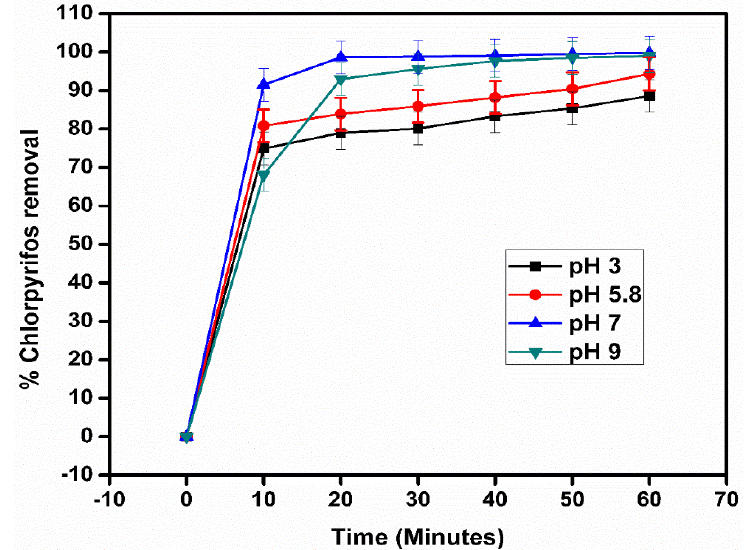
Figure 13. Degradation of 1000 ppb chlorpyrifos using 0.1 g of Mn-WO 3 /SnS 2 at different pH values.